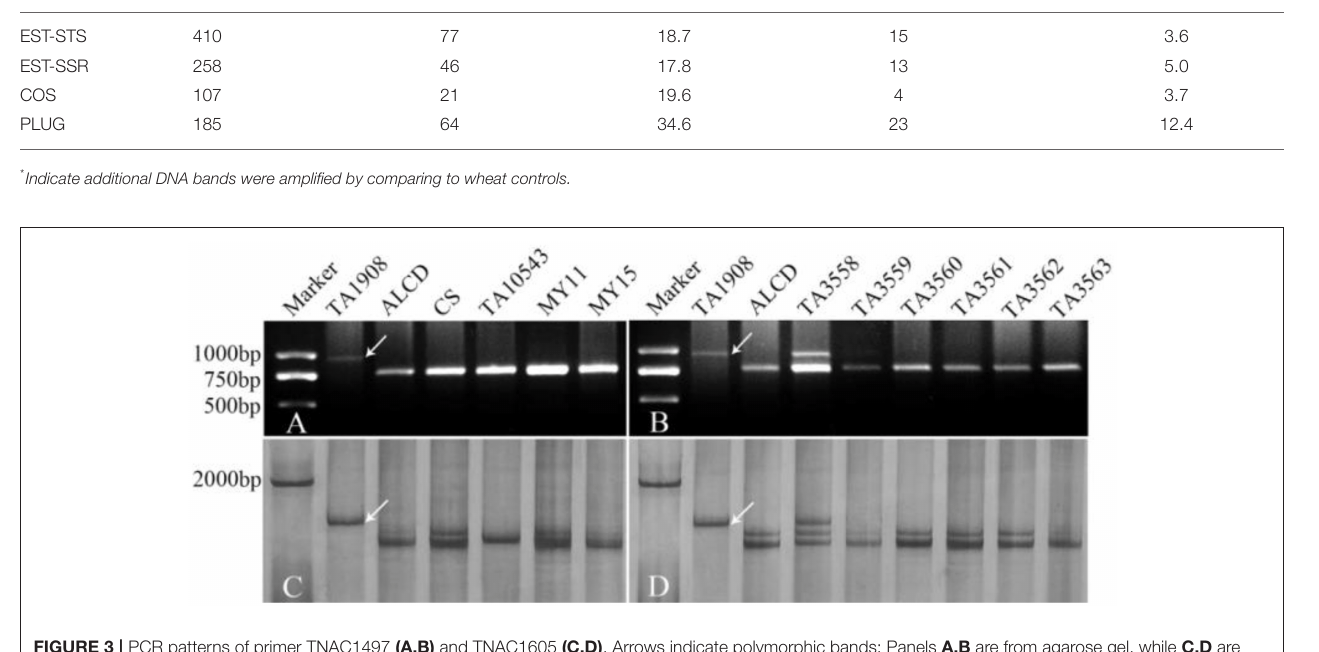
TABLE 2 | Primers screened and relative information of molecular markers obtained. Primer Number of primer Number of polymorphic screened primers *